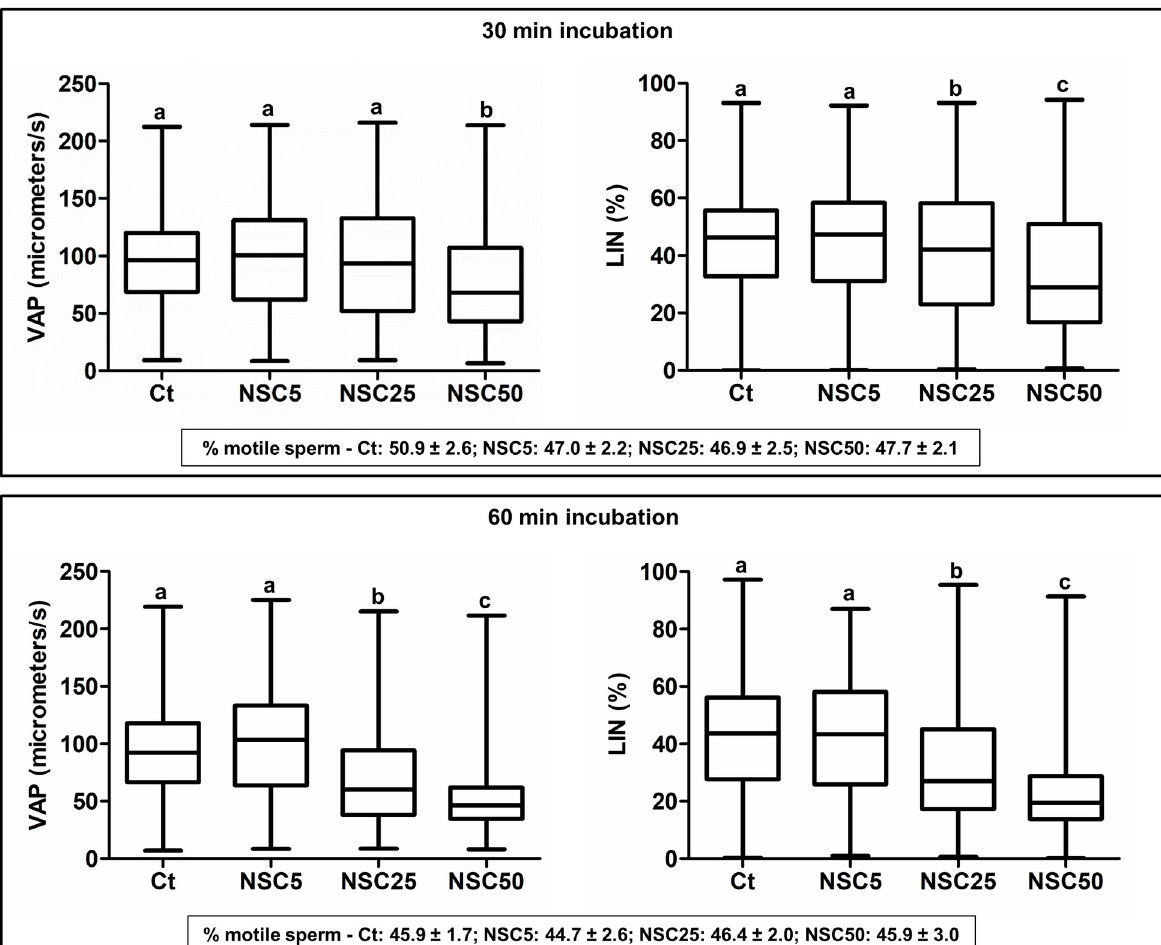
Fig 1. RAC1 inhibition affects motility parameters of wild type mouse sperm. Box plots (showing the median and first and third quartiles) with whiskers (from minimum to maximum) of average path velocity (VAP) and linearity (LIN) of sperm after incubation without (Ct: control) or with different concentrations of NSC23766 (NSC, μ M) for 30 min (n = 2705, 2185, 2040 or 1581 sperm for Ct, NSC5, NSC25 or NSC50, respectively) and 60 min (n = 2178, 1597, 1431 or 1269 sperm for Ct, NSC5, NSC25 or NSC50, respectively). For each condition, the percentage of motile sperm (mean ± standard error, n = 11 samples) is also shown (bottom boxes). Statistically significant differences between treatments are indicated by distinct letters ( Ps < 0.001).